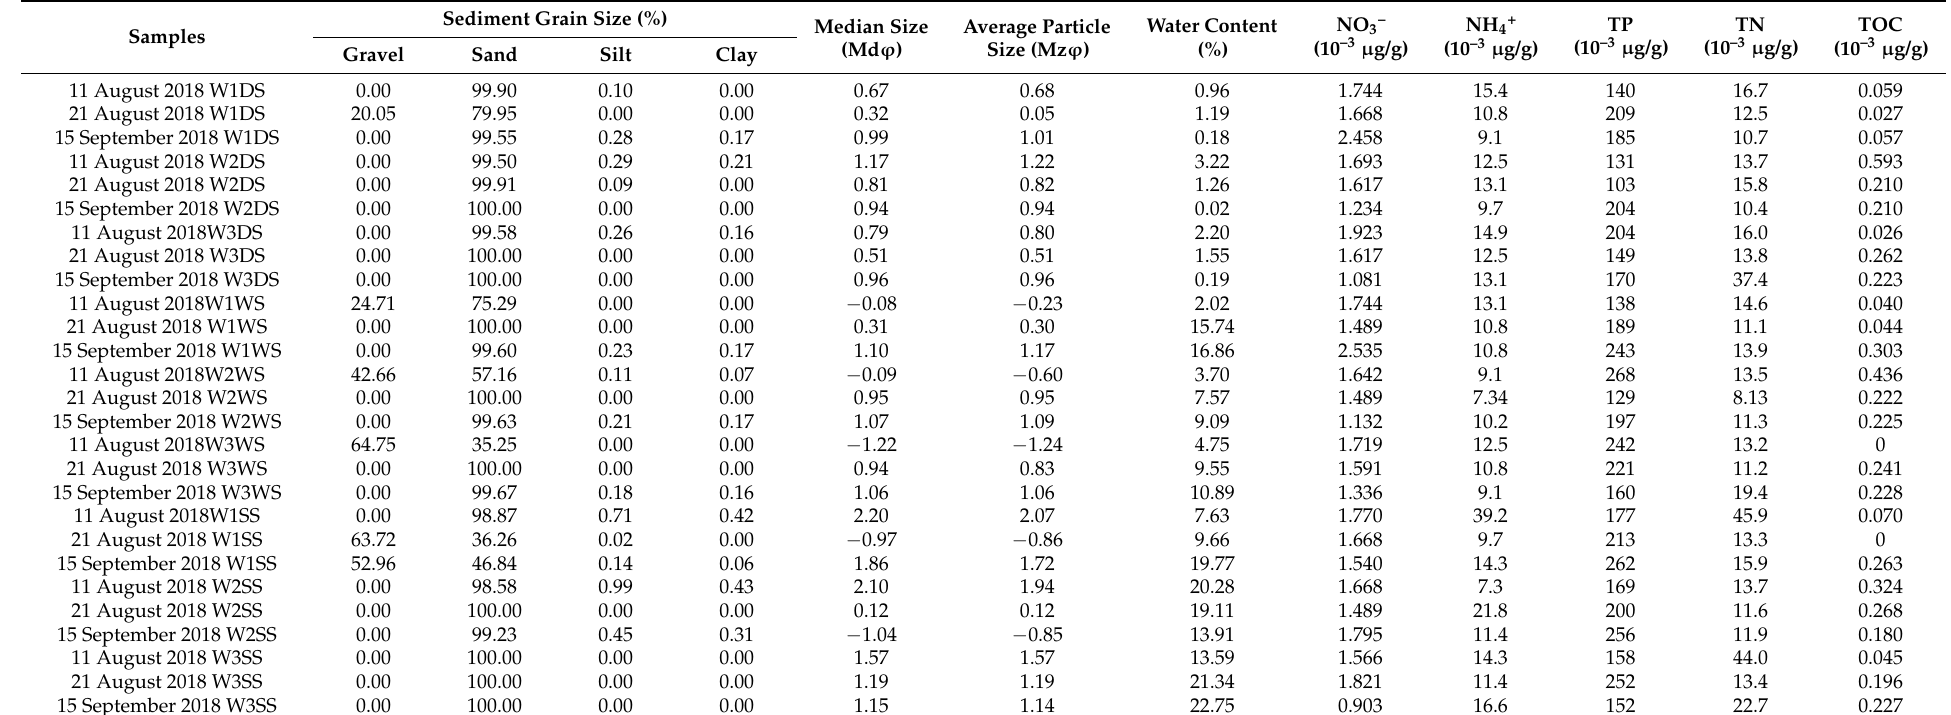
Table 2. Physical-chemical factors of beach